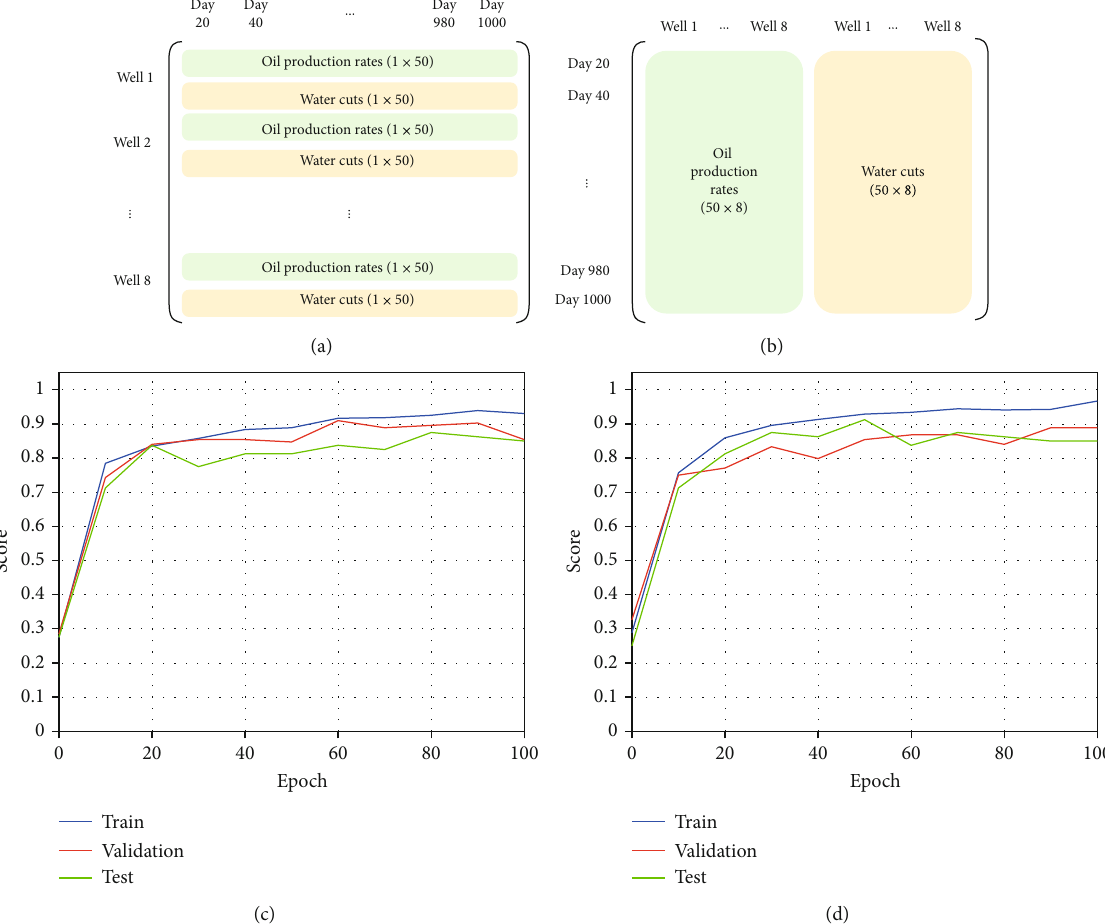
Figure 12: The e ff ect of data arrangement in the CNN. Data arrangement for (a) the case 1 and (b) the case 2 and accuracy scores for (c) the case 1 and (d) the case